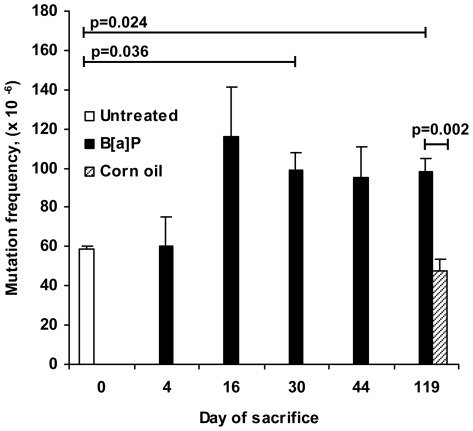
Mutation frequencies in the liver of Big Blue® mice exposed to B[a]P.The Mf values are given as means (per 106 pfu) ±SE, and the days of sacrifice are indicated on the x-axis. Mice sacrificed at day 0 are untreated controls. Treatments groups and number of mice (n) are given: 0 days untreated (n = 3); 4 days B[a]P (n = 4); 16 days B[a]P (n = 6); 30 days B[a]P (n = 5); 44 days B[a]P (n = 6); 120 days B[a]P (n = 6) and 120 days corn oil (n = 6). Statistically significant differences (Mann-Whitney) between the Mf of the groups and p-values are indicated.